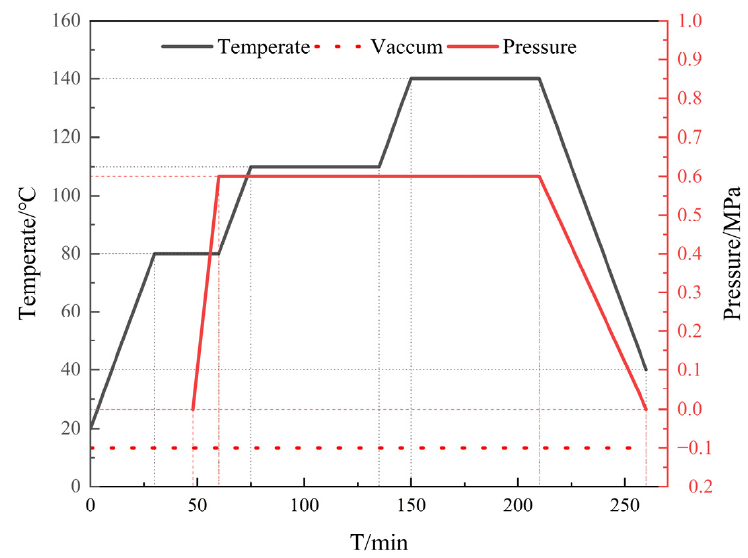
Figure 2. Laminate temperature and pressure curve.